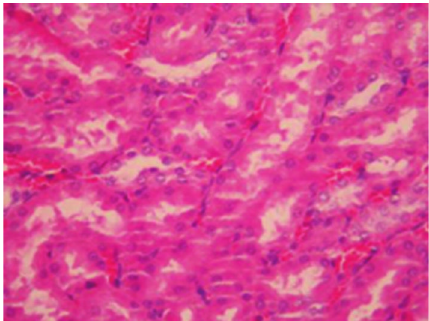
Figure 6: Treated group 28 days; turbidity and degeneration of renal tubular epithelial cells as well as vascular congestion; HE × 200.